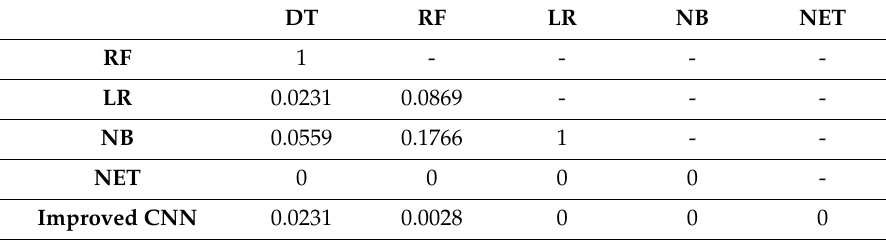
Table 10. Holm–Bonferroni test of prediction on the PSC dataset for G-measures.